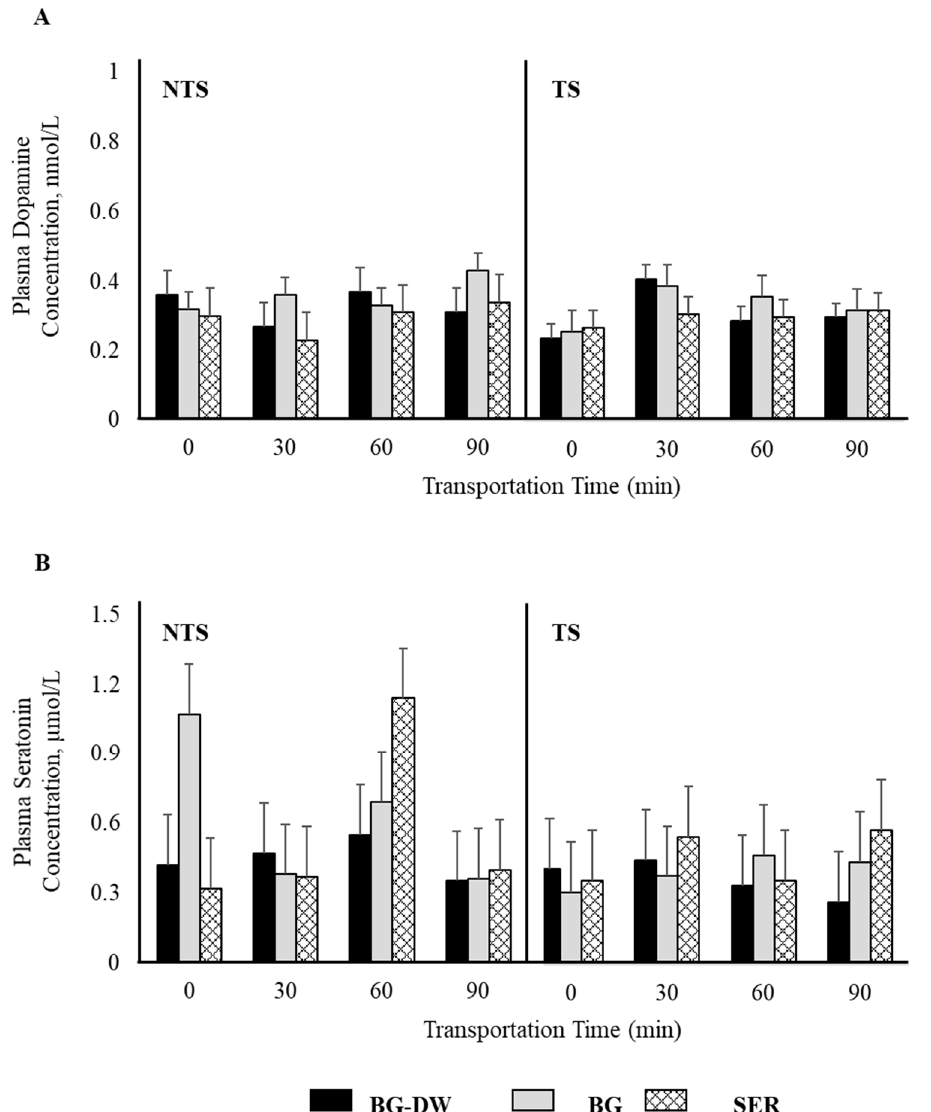
Figure 3. Effects of Diet (BG-DW: bermudagrass hay—dewormed; BG: bermudagrass hay; SER: sericea hay), Stress Treatment (ST; NTS: non-transported; TS: transported), and Time on plasma ( A ) dopamine (ST × Time, p = 0.07) and ( B ) serotonin (ST × Time, p < 0.05) concentrations in goats. Bars represent means with SEM.